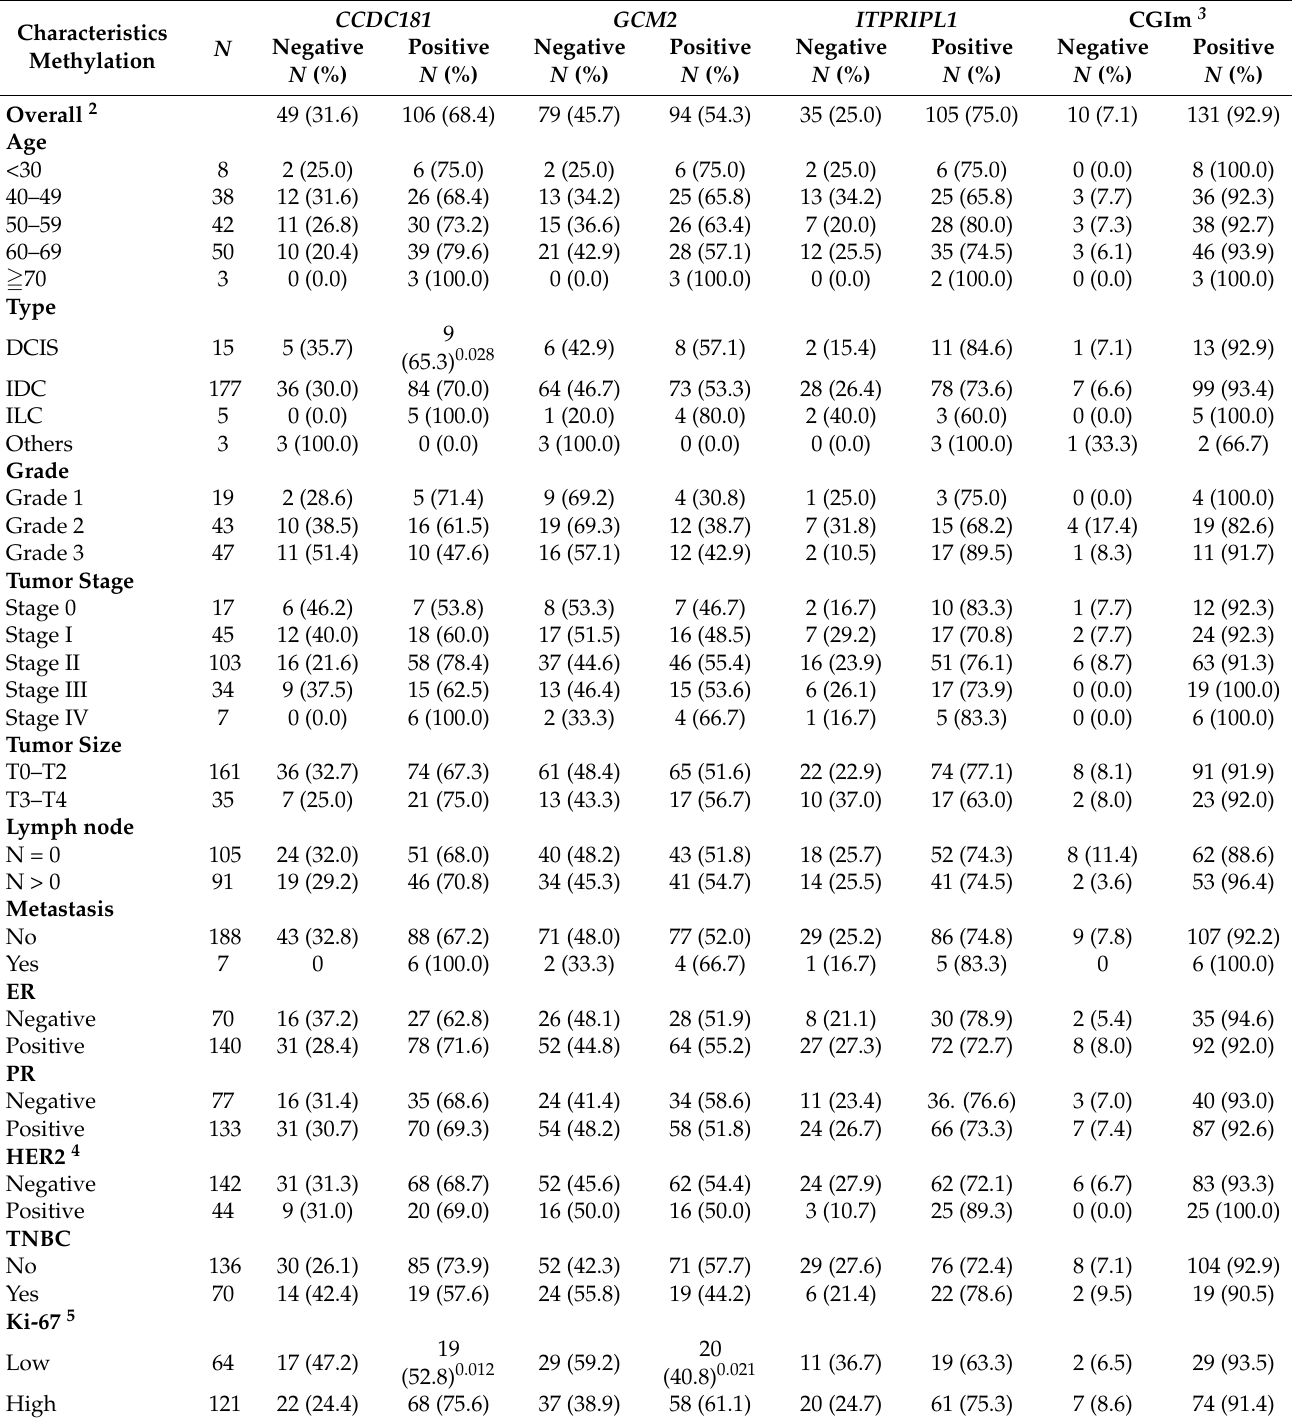
Table 3. CCDC181, GCM2 and ITPRIPL1 promoter methylation in relation to clinical parameters in plasma of Taiwanese breast cancer patients 1